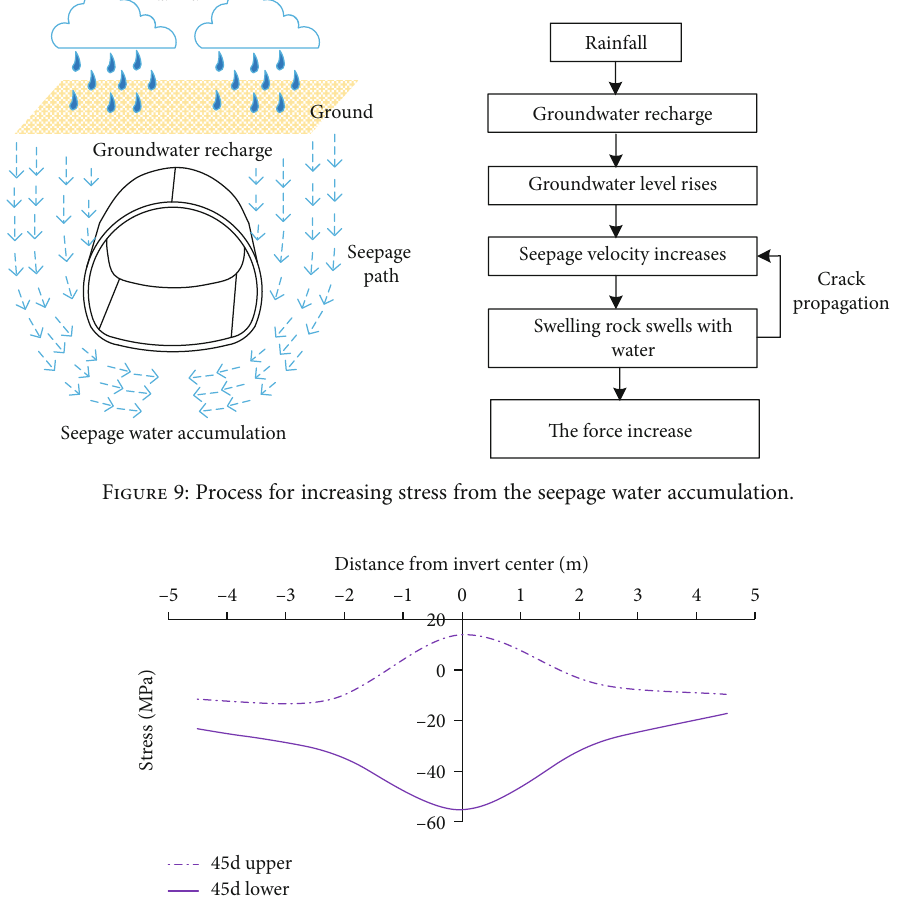
Figure 10: Stress on rebar on day